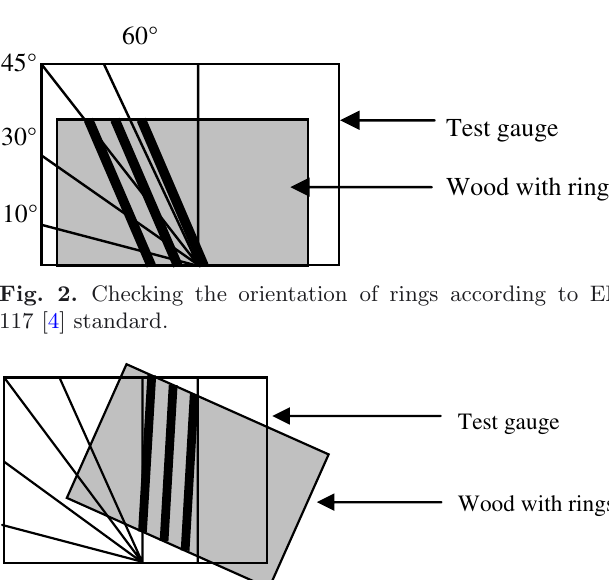
Fig. 1. Test gauge for wood sample selection ( ± 1 mm, ± 1 ◦ ).